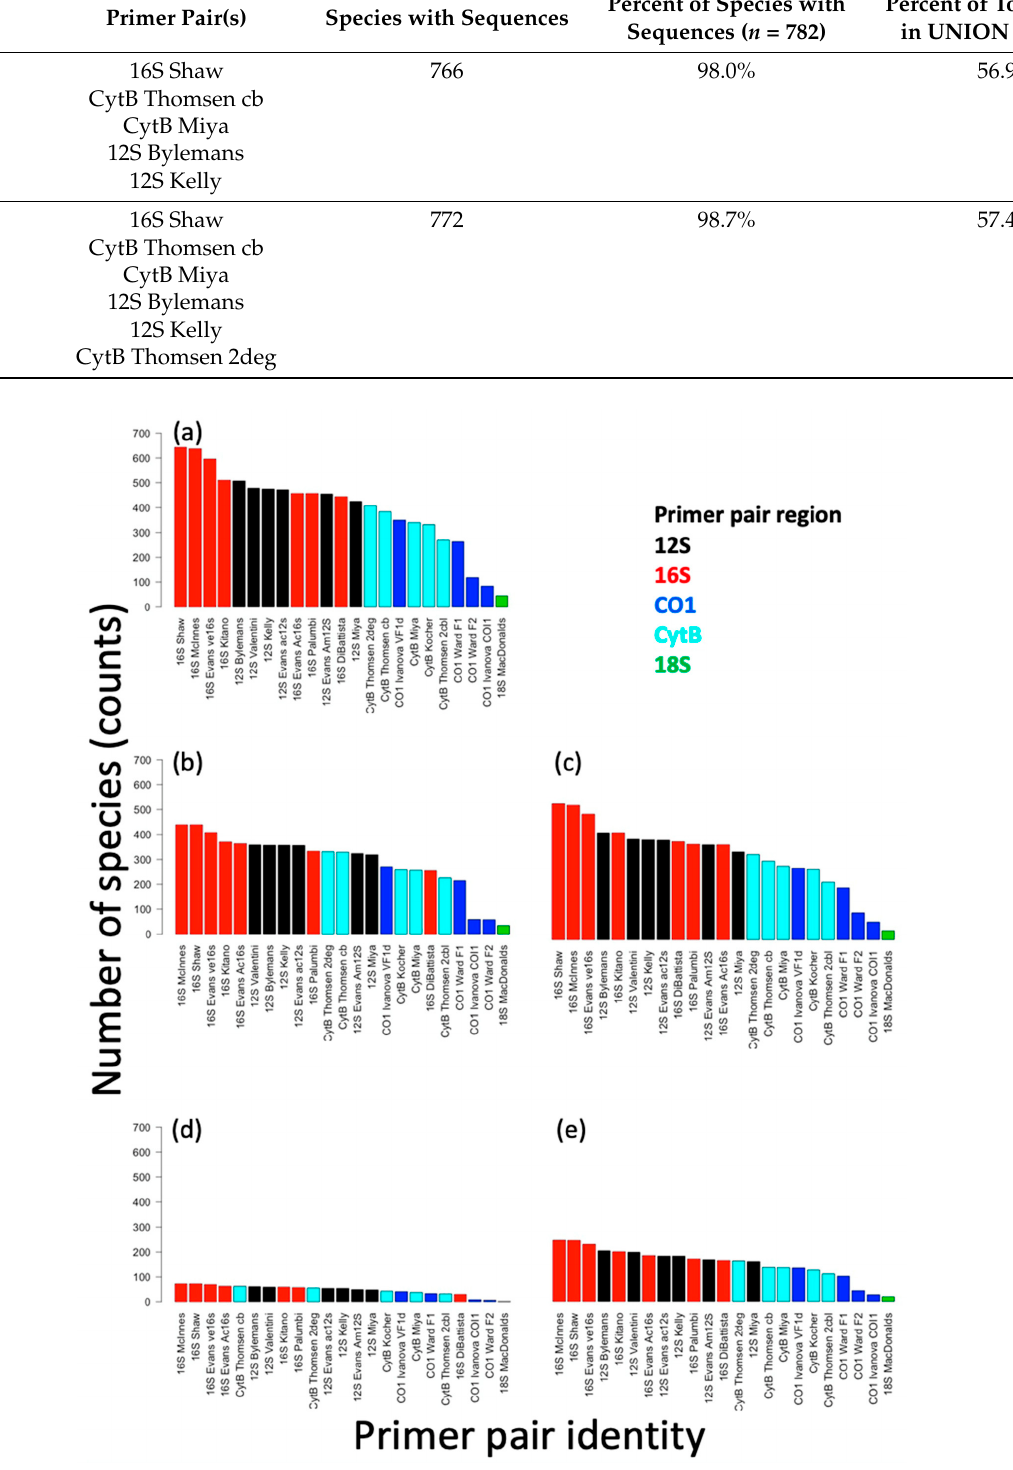
Figure 3. Bar charts of primer pair coverage for all species lists in the MRB (( a ): UNION), using the GAPeDNA default (( b ): GAP), the curated MRC database (( c ): MRC) and the two subset databases by migratory fish species (( d ): ZIV) and by country of Cambodia (( e ): FCFB). Primer pair names are consistent with GAPeDNA identities [10]. Primer locations are color coded and the 16S Shaw [10,45] and 16S McInnes [10,25] primer pairs are consistently the best performing primer pairs across